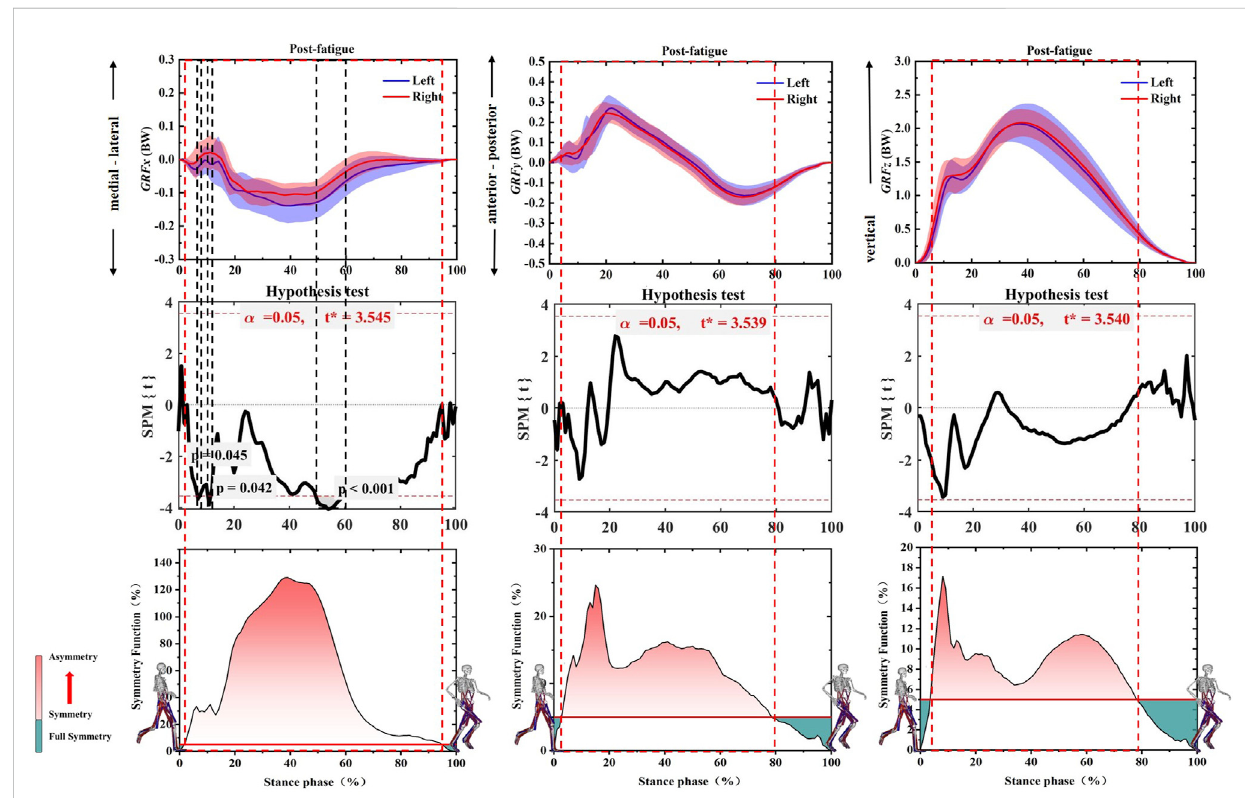
FIGURE 3 Illustration of SF degree and SPM test of GRFx, GRFy, and GRFz during the whole gait stance phase after Running-induced Fatigue Protocol Test. Note:Thereddottedboxesrepresentasymmetricalintervals.TheblackdottedboxesrepresentaSigni fi cantdifference.Thered fi llrepresentsthedegree of asymmetry, and the darker the color, the more asymmetry. The green fi ll represents full symmetry. GRFx: medial-lateral direction of GRF, GRFy: anterior-posterior direction of GRF, GRFz: vertical direction of